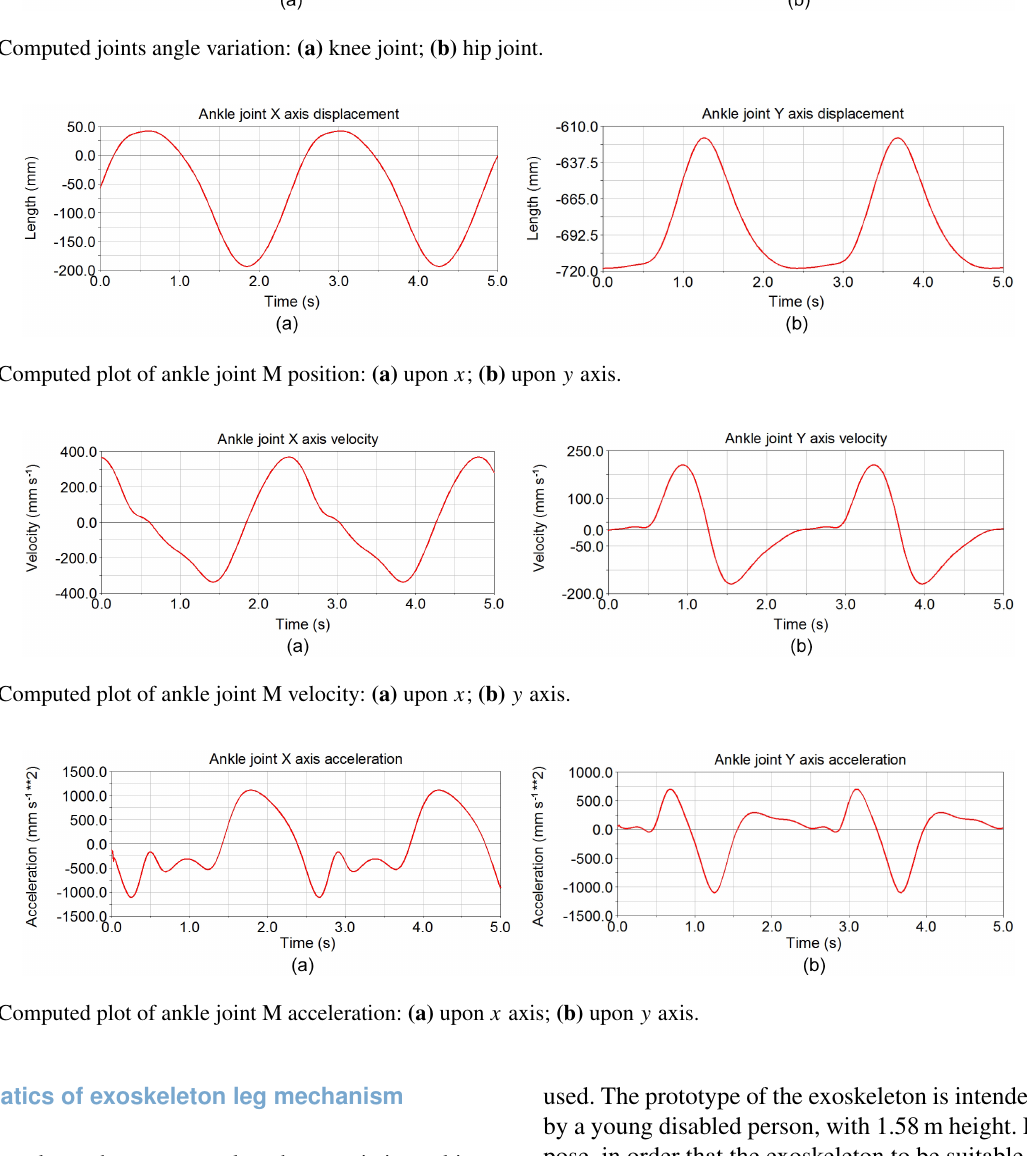
4 Kinematics of exoskeleton leg